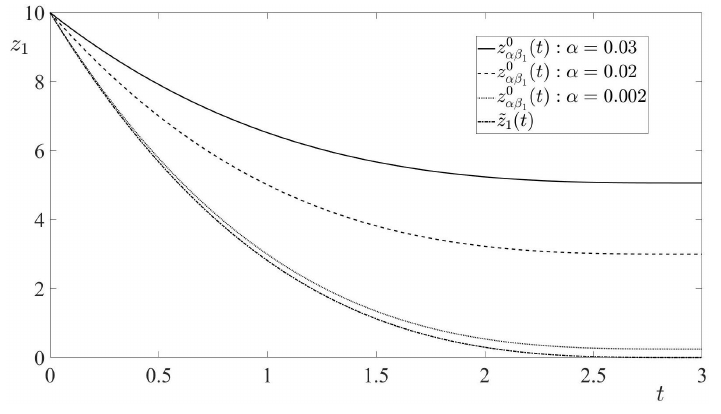
( t ) and limiting function ˜ z αβ 1